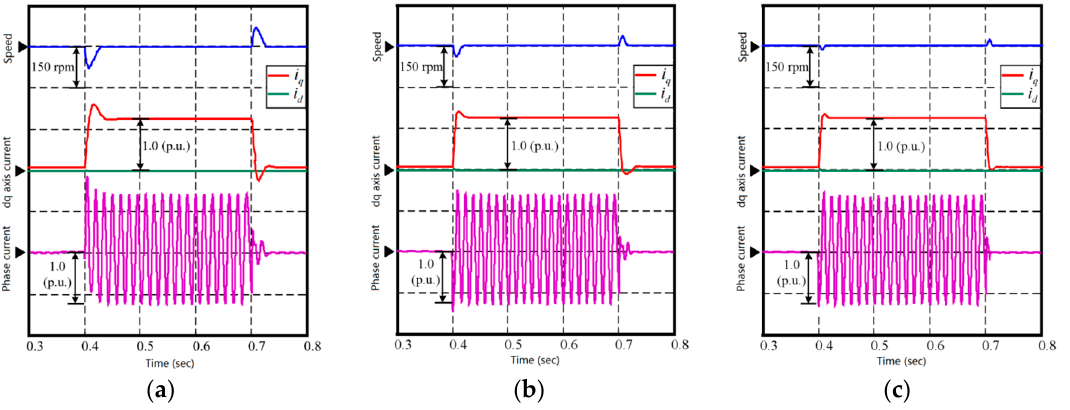
Figure 6. Simulation results under load sudden change condition: ( a ) TBC; ( b ) AIBC_FP; ( c ) Figure 6. AIBC_AWPSO. Table 6 summarizes the performance comparison of three control methods above. Table 6. Performance comparison of three control methods. Table 6. Performance comparison of three control